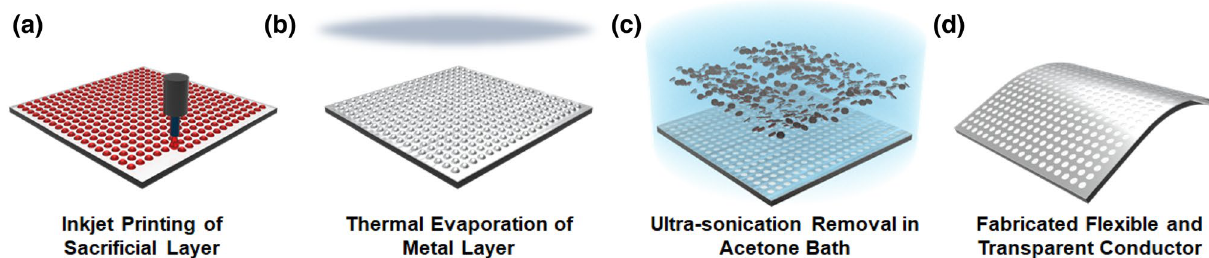
Figure 1. Schematic illustration for the fabrication procedure of a transparent electrode with a negative pattern of an inkjet-printed dot array. ( a ) PR ink-jet printing on the glass; ( b ) thermal evaporation of aluminum; ( c ) the removal of the printed PR array; ( d ) the metal grid